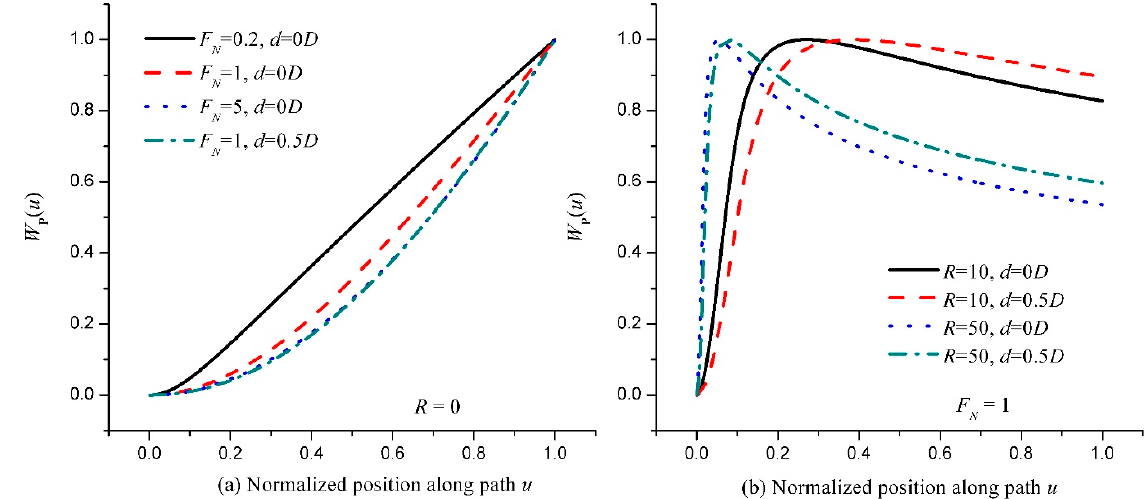
Figure 3. Normalized path-weighting function W P ( u ) for the covariance of piston amplitude for plane waves. ( a ) Point sources with various F N ( F N = D 2 / λ L ) and d (the distance between the aperture centers) values. ( b ) Distributed sources with various R ( R = D S L/DL S ) and d values when F N = 1.